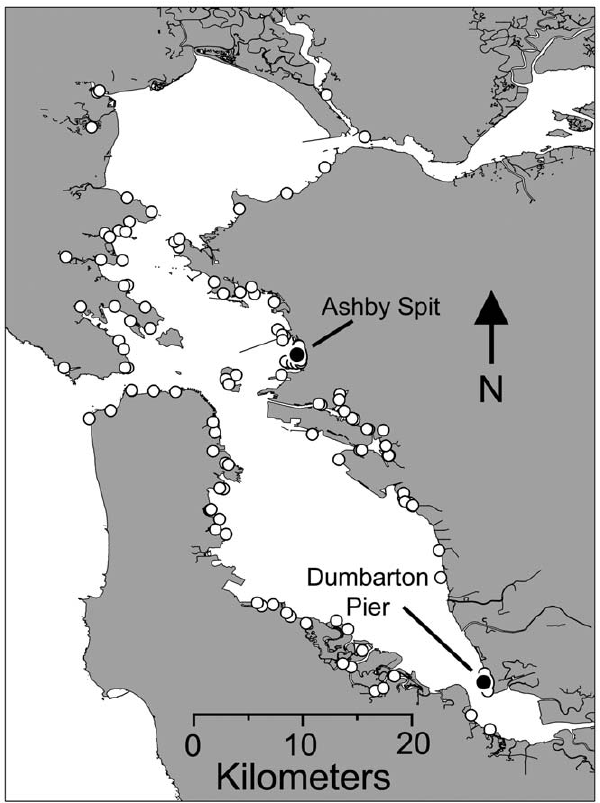
Figure 1. Locations of intertidal surveys in San Francisco Bay (California, USA) completed between 2001 and 2008. Black circles indicate locations of large populations of Littorina littorea ; white circles indicate locations where L. littorea was not detected.